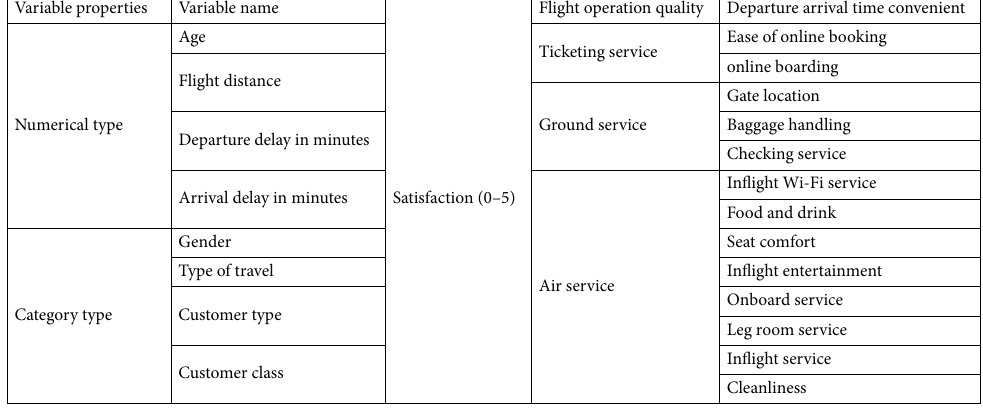
Table 2. Variable name and attribute.